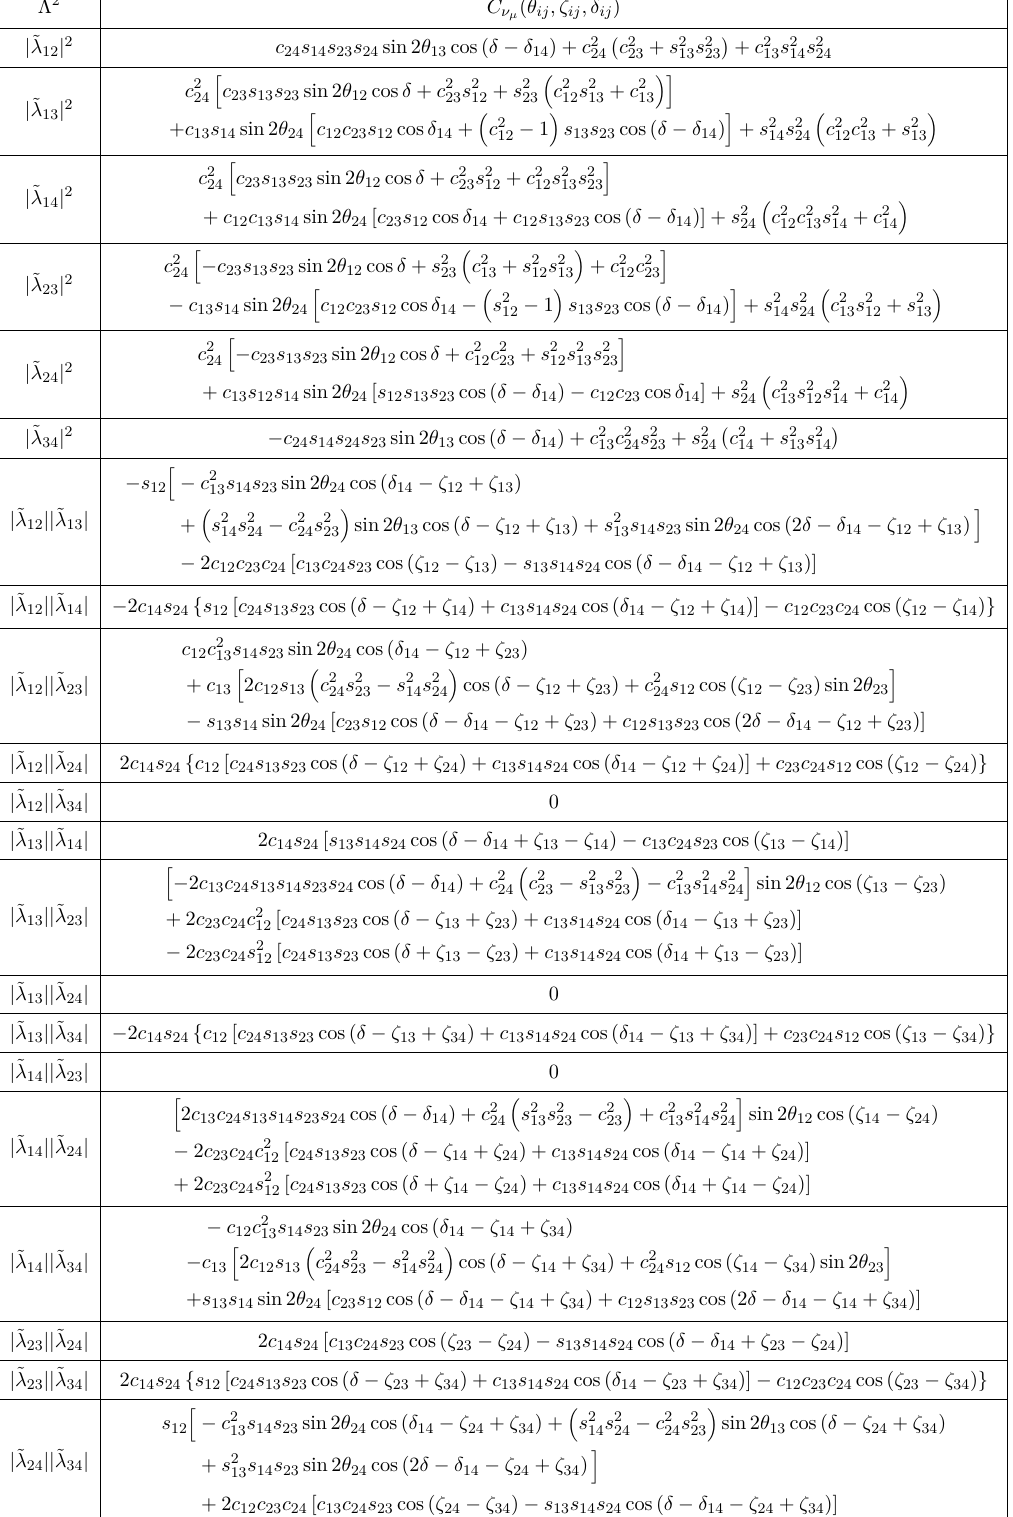
Table 2 . TMMs and corresponding coefficients for the calculation of eq. (2.6) for muon